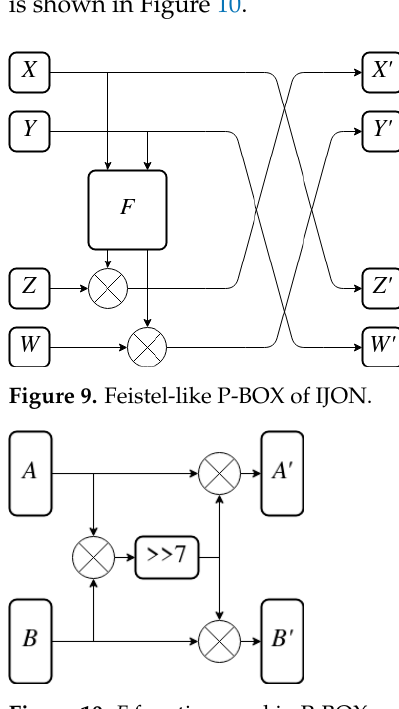
Figure 10. F function used in